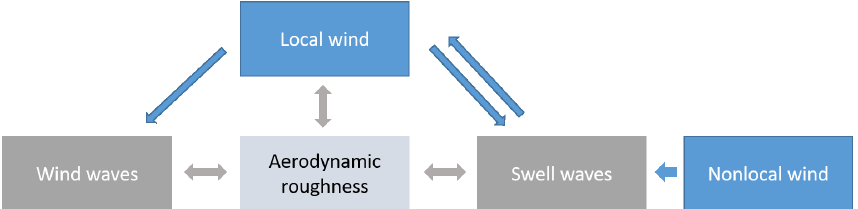
Figure 1. Schematic of the wind–wave interactions, upward momentum transfer to the atmosphere or negative shear is possible in case of swell waves. Swell waves are generated by nonlocal wind and can travel long distances. Local winds further influence swell waves but can also produce wind waves through downward momentum transfer. In atmospheric models, a parameterization of the aerodynamic roughness length is used to represent all these